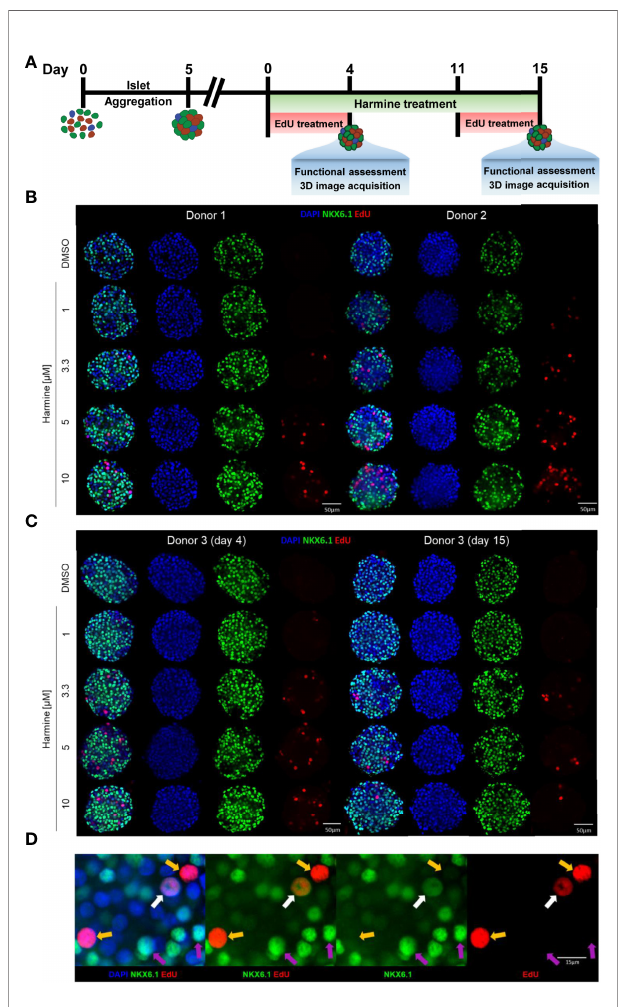
FIGURE 2 | EdU and NKX6.1 labeling reveals dose and donor dependence of harmine-induced proliferation in human islet MTs. (A) Schematic representation of islet MT harmine treatment scheme. (B, C) Representative immuno fl uorescence images of islet MTs generated from three different donors, treated with DMSO or harmine at a concentration of 1, 3.3, 5, or 10 m M, for a duration of (B) 4 days for Donors 1 and 2 or (C) 4 days or 15 days for Donor 3. Scale bar, 50 m m. (D) Representative immuno fl uorescence image of a proliferating b -cell (white arrow) and proliferating non- b -cells (yellow arrow). Purple arrows indicate non-proliferating b -cells for comparison. (D) Scale bar, 15 m m. Images were generated from central Z-stacks and with the same thresholding settings within each